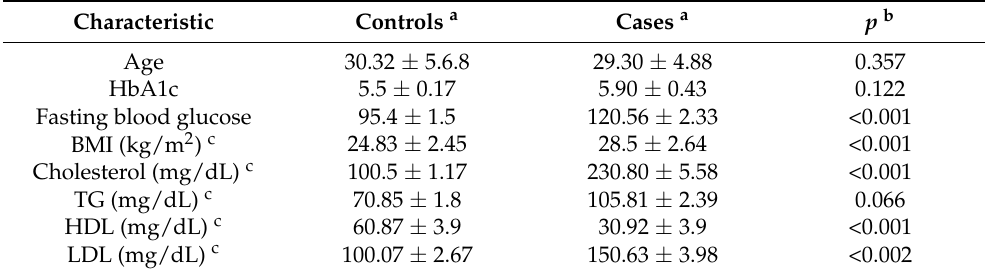
Table 3. Comparison of clinical and biochemical characteristics of T2DM patients and